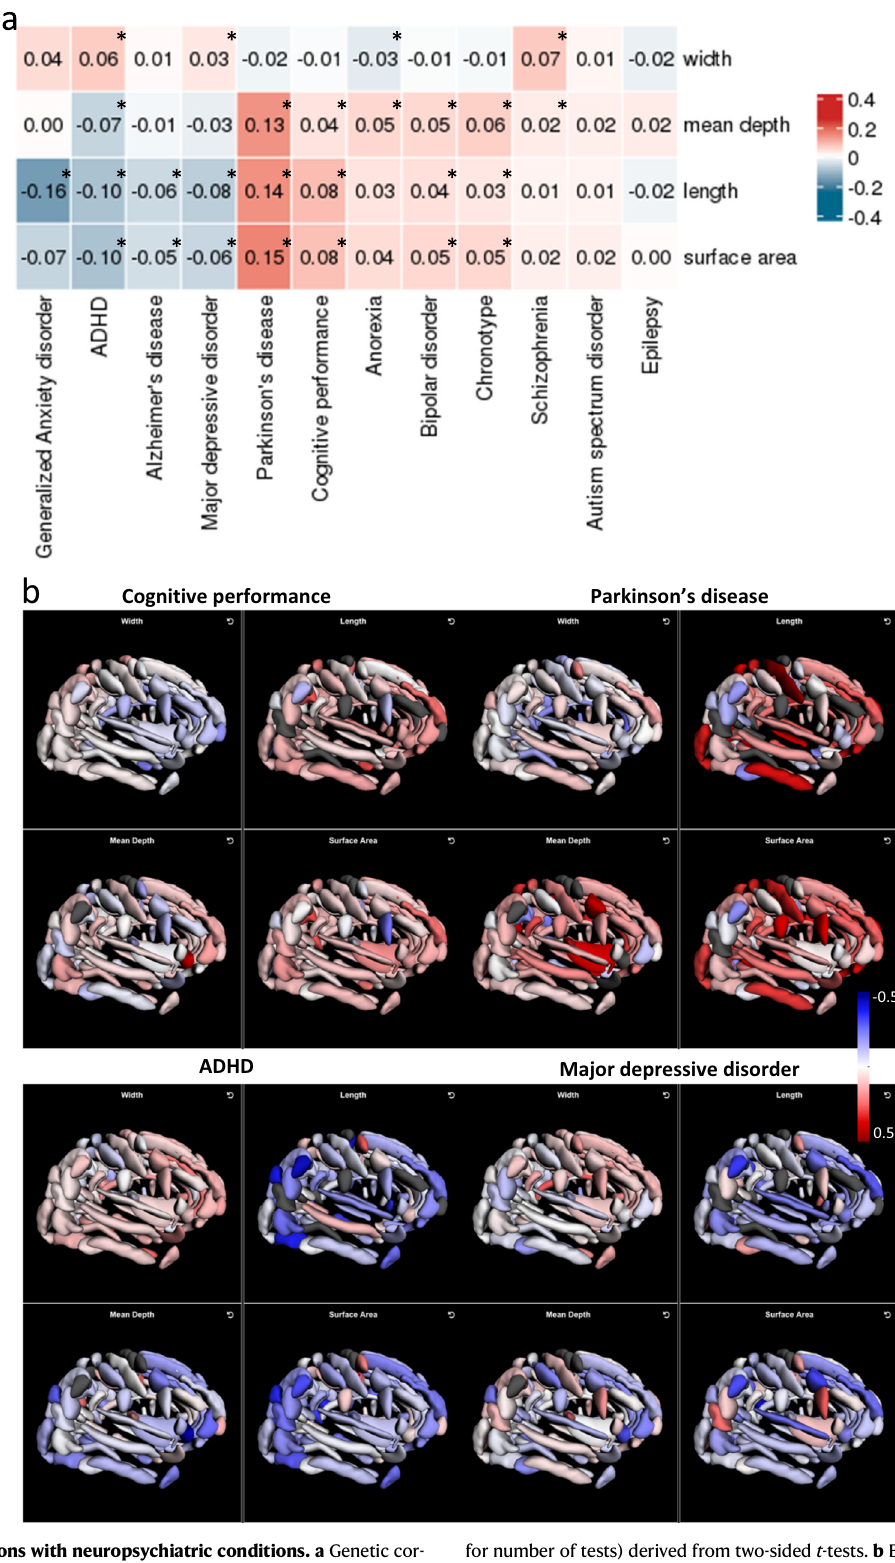
for number of tests) derived from two-sided t -tests. b Examples of genetic corre- lations across brain sulcal folds with cognitive performance, Parkinson ’ s disease, attention de fi cit hyperactive disorder (ADHD) and major depressive